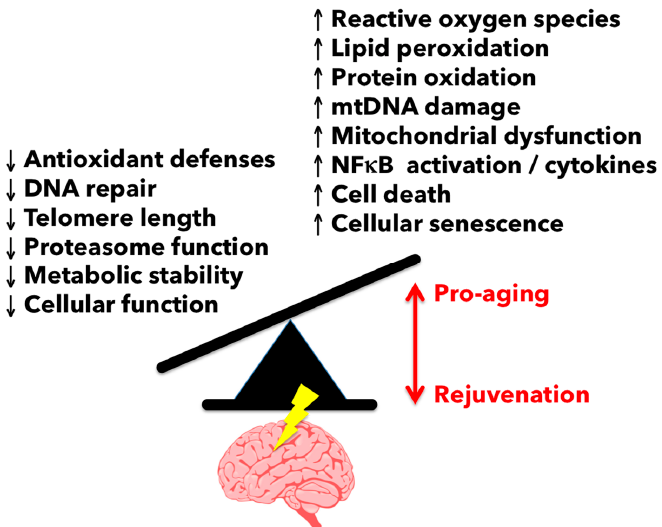
Figure 4. Imbalance between oxidative stress and antioxidant defenses in the aging brain.